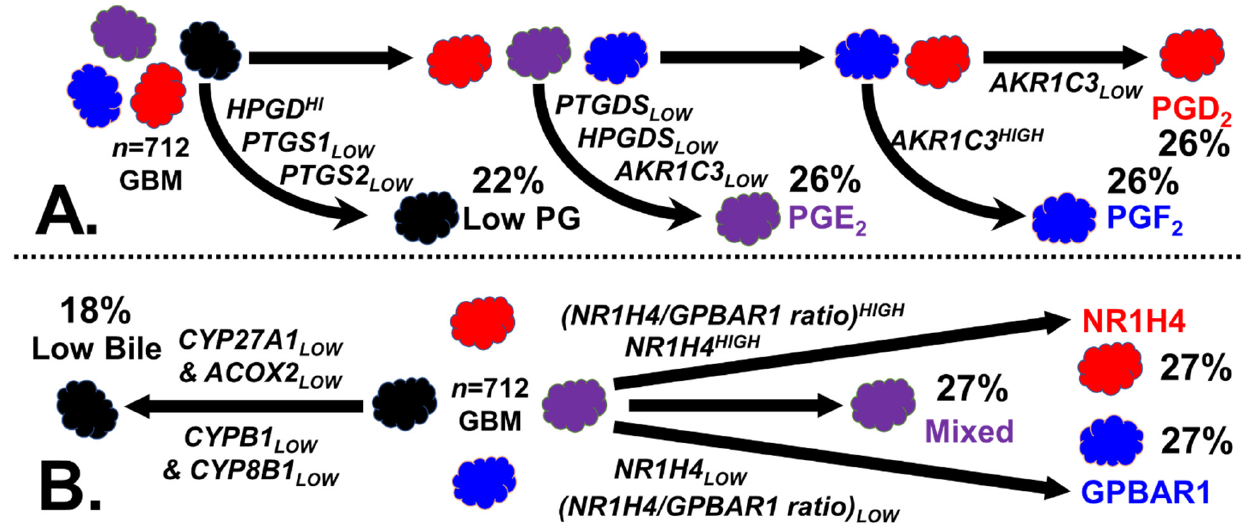
Figure 8. The procedure used for prostaglandin and bile GBM stratification. ( A ) How GBM tumors were stratified by their ability to generate prostaglandins is illustrated. Tumors incapable of gener- ating prostaglandins are selected based on the PTGS1/2 and HPGD levels. Tumors incapable of syn- thesizing PGD 2 /F 2 , with low PTGDS, HPGDS, and AKR1C3, are placed in the PGE 2 group. AKR1C3 levels are used to differentiate between the PGD 2 and PGF 2 groups. ( B ) Tumors under-expressing genes of the ‘acidic’ bile synthesis pathway are defined as ‘Low Bile’. Ratios of the two receptor transcripts are generated, and transcripts are ranked with respect to GPBAR1 and NR1H4. This pro- cedure gives rise to three equally sized phenotypes: NR1H4 (GPBAR)1 LOW , GPBAR1 (NR1H4) LOW , and, finally, ‘Mixed’, which is a group of tumors that express both receptors.